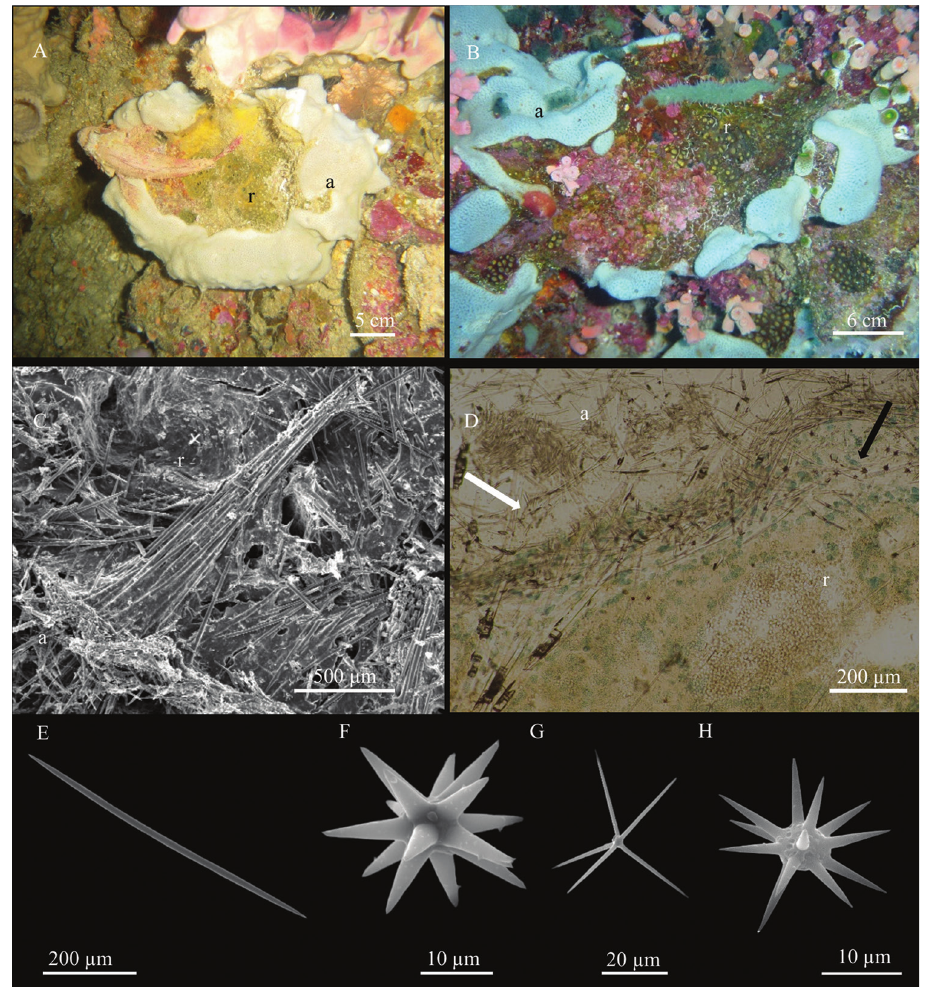
Figure 5. Rhabdastrella distincta (Thiele, 1903) A, B specimens in situ ( r ), partially covered by the epibiotic sponge Amphimedon cf. sulcata Fromont, 1993 ( a ) specimen of Figure 5A is BU-575, that of Figure 5B is BU-560 C SEM image of a cross section of R. distincta ( r ) showing the radial tracts of oxeas in proximity of the external part, a indicates the epibiotic sponge A. cf. sulcata D histological prepara- tion of R. distincta ( r ) and A. cf. sulcata ( a ) showing spherasters (black arrow) in the peripheral part, and oxeas of R. distincta (white arrow) penetrating the tissues of A. cf. sulcata E oxea F spheraster G oxyaster H